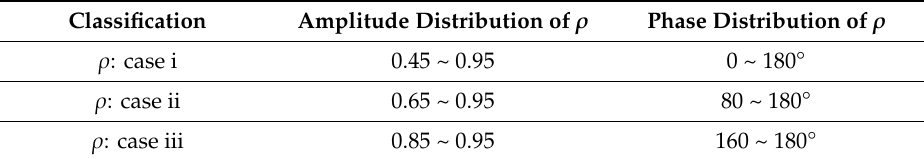
Table 2. Random distribution parameters of the reflection coefficient (cid:2025) . Classification Amplitude Distribution of (cid:2251)